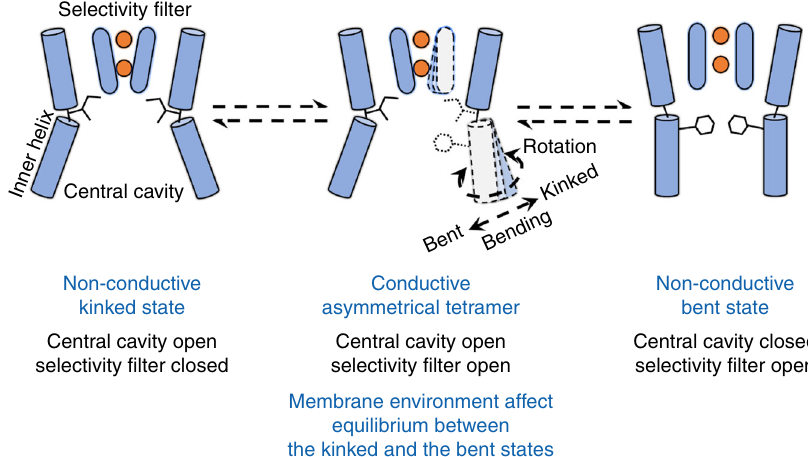
Fig. 6 Hypothetical crosstalk between the two gates of MthK. The channel is nonconductive due to closed selectivity fi lter if all four subunits are in the kinked state (left). Conformational transition from the kinked to the bent state opens the selectivity fi lter, but promotes dehydration of the central cavity (middle). The central cavity is ef fi ciently dehydrated, and the channel is in another nonconductive state if all four subunits are in the bent state (right). The conductive state is found for asymmetrical tetrameric structures (middle). Lipid – protein interactions affect the conformational equilibrium between the kinked and bent states, which in turn regulates ion permeation rate. Directions of helix bending and rotation in the process of conformational transition are indicated by dashed